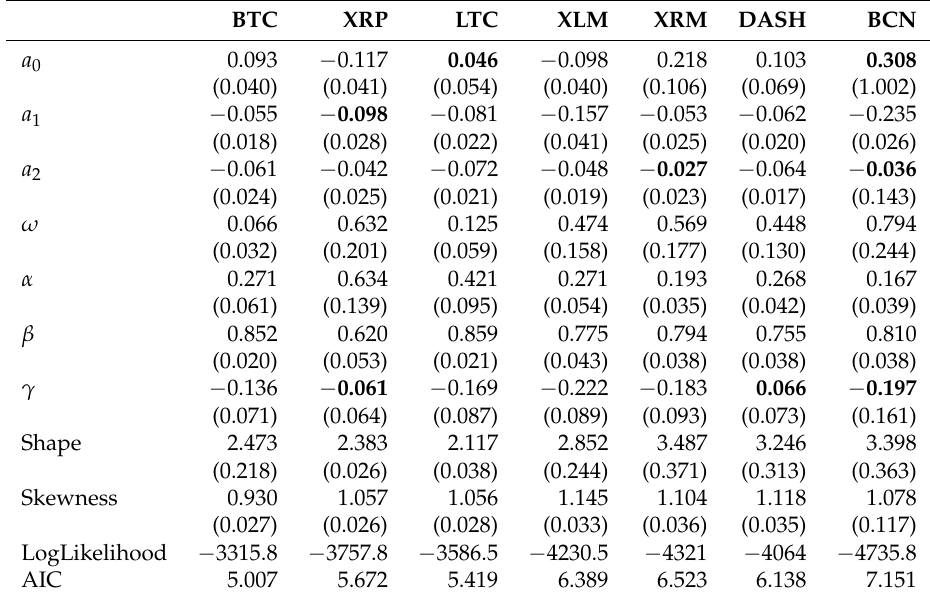
Table 3. Parameter estimates of AR(2)-TGARCH(1,1) ∼ Skewed t volatility model. BTC XRP LTC XLM